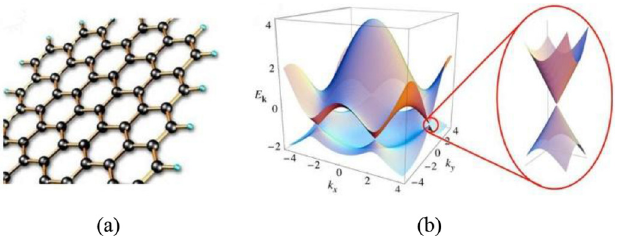
Fig. 1. (a) The planar hexagon dot array structure of graphene. (b) The energy spectrum and energy band diagram of